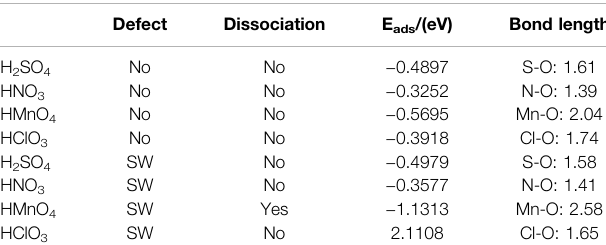
TABLE 2 | Reaction of single component on the surface of graphene with